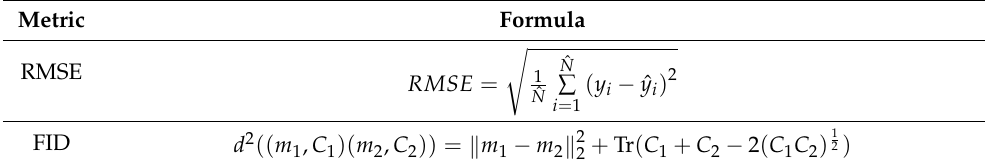
Table 1. Evaluation metrics used to assess the proposed algorithm’s performance.